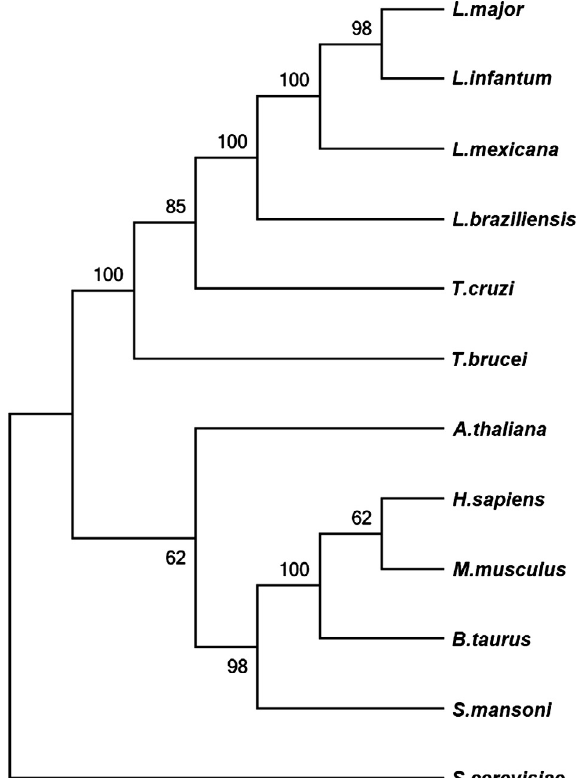
Figure 1. Bioinformatics analysis. The relationship of Leishmania